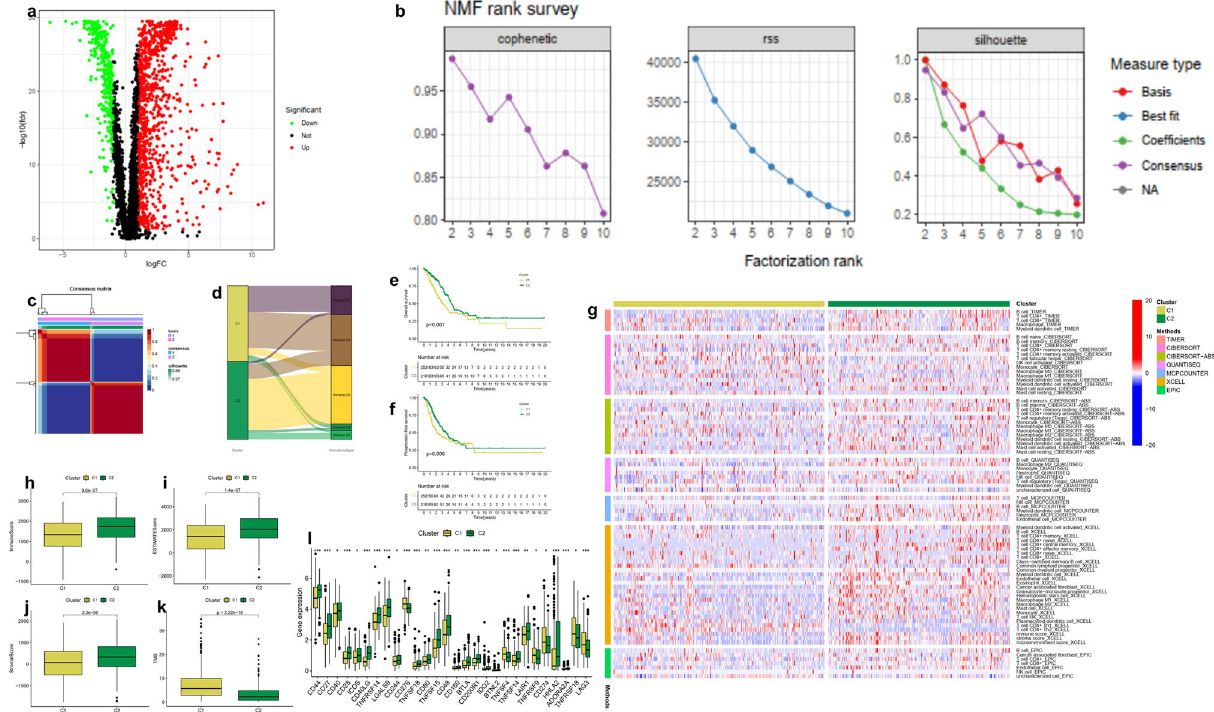
Figure 1. Two subgroups of LUAD were identified based on TME. ( a ) Identification of differentially TME- related expressed genes in the LUAD and normal groups. ( b ) The cophenetic coefficient, residual sum of squares, and silhouette in NMF analysis. ( c ) The consensus map of NMF analysis. ( d ) The Sankey map of molecular subtypes compared with existing molecular immune subtypes. ( e ) Analysis of the OS of C1 and C2. ( f ) PFS of C1 and C2. ( g ) Immune cell infiltration in the two clusters. ( h ) Immune cell scores in the two clusters. ( i ) Stromal cell scores in the two clusters. ( j ) ESTIMATE scores in the two clusters. ( k ) TMB in the two clusters. ( l ) The differences in the expression of 28 immune checkpoint molecules in the two clusters.